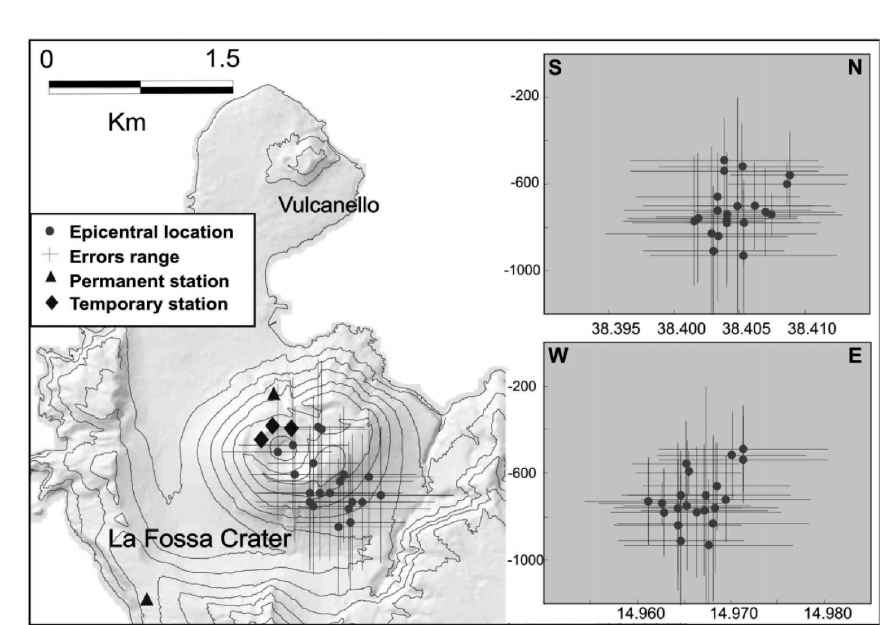
Fig. 4. Epicentral map, NS and EW cross-sections of the located